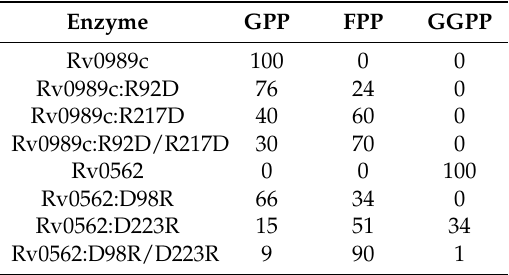
Table 1. Product profiles of Rv0562, Rv0989c, and associated mutants. Assays were completed with purified enzyme in the presence of 100 µ M DMAPP and 10 µ M IPP for 12 hours prior to dephosphorylation and extraction with organic solvent. Organic extracts were concentrated and analyzed via GC-FID. Product identity was confirmed via comparison to dephosphorylated authentic standards prior to integration of peak area. Product profile is represented as percentage of total isoprenoid peak areas. Enzyme GPP FPP GGPP Rv0989c 100 0